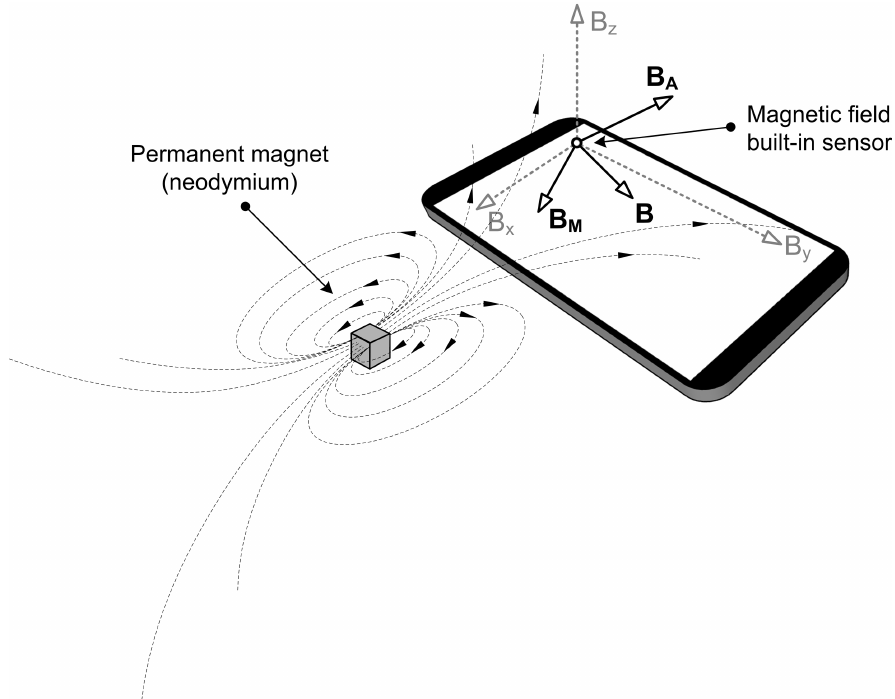
Figure 1. The impact of a permanent magnet put in the vicinity of a mobile